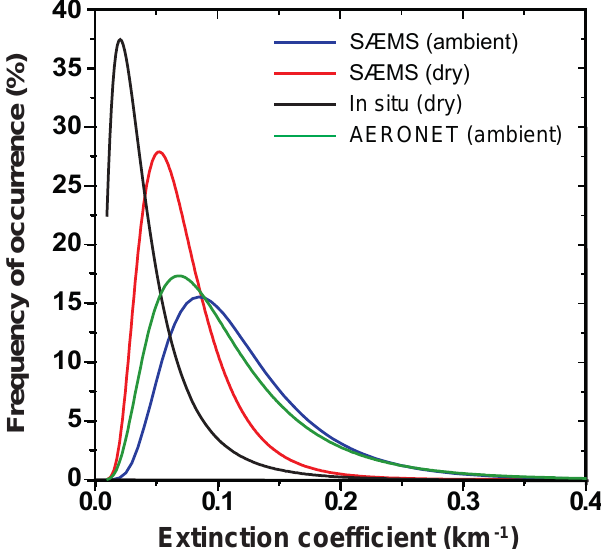
Figure 10. Frequency of occurrence of 550nm particle extinction coefficient measured with SÆMS (ambient) at TROPOS, Leipzig, between 13:00 and 17:00UTC of each day in the year of 2009 (blue line). For comparison, the respective distribution for the PBL-mean extinction coefficient (ambient, green) is shown. These values are derived from AERONET sun photometer observations of the 500nm particle optical depth divided by the PBL depth, which was esti- mated from GDAS1 model data. The red SÆMS (dry) curve shows the distribution of humidity-corrected SÆMS 550nm particle ex- tinction values (for 0% relative humidity). The black distribution (in situ, dry) shows the 550nm extinction values calculated from in situ observations of the dry particle size distribution at the roof of the TROPOS building exclusively for the time period from 13:00 to